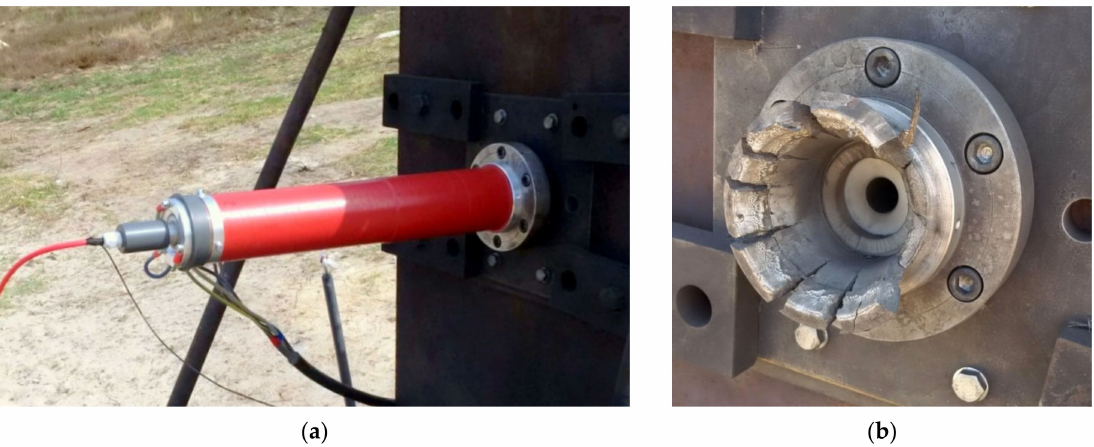
Figure 5. Photographs of FCG prepared on the test stand ( a ), and after the explosion and current generation process ( b ).